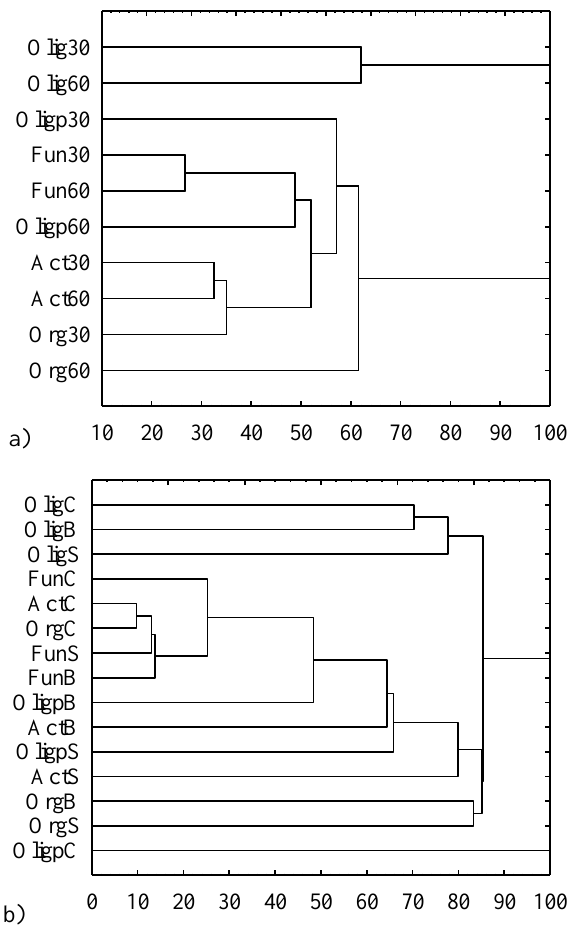
Figure 2. Similar responses of soil microorganisms to Successor T 550 SE. ( a ) to the factor of time; ( b ) to the factor of substance. Org—organotrophic bacteria; Oligp—sporeforming oligotrophic bacteria; Olig—oligotrophic bacteria; Act—actinobacteria; Fun—fungi; C—control; B—bentonite; S—straw; 30—30 days; 60—60 days.